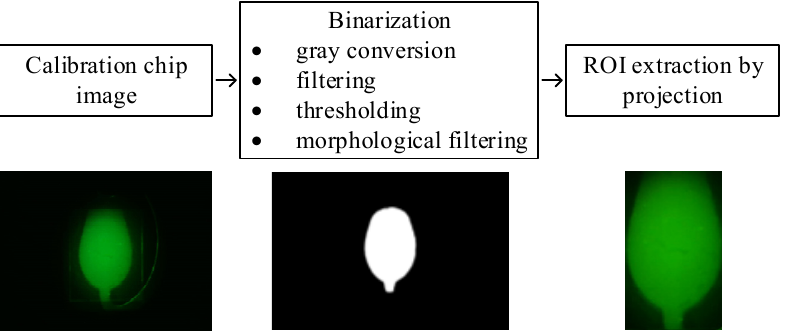
Figure 7. Image processing steps to obtain ROI, i.e., the chamber, for fluorescence analysis.